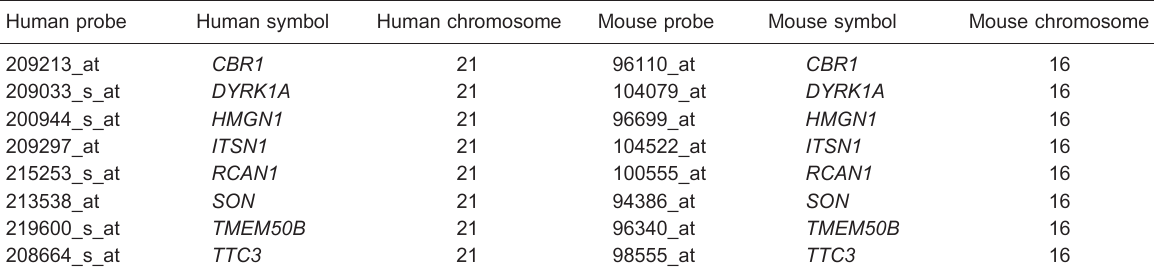
Table 1. The up-regulated genes observed in human (chromosome 21) and mouse (chromosome